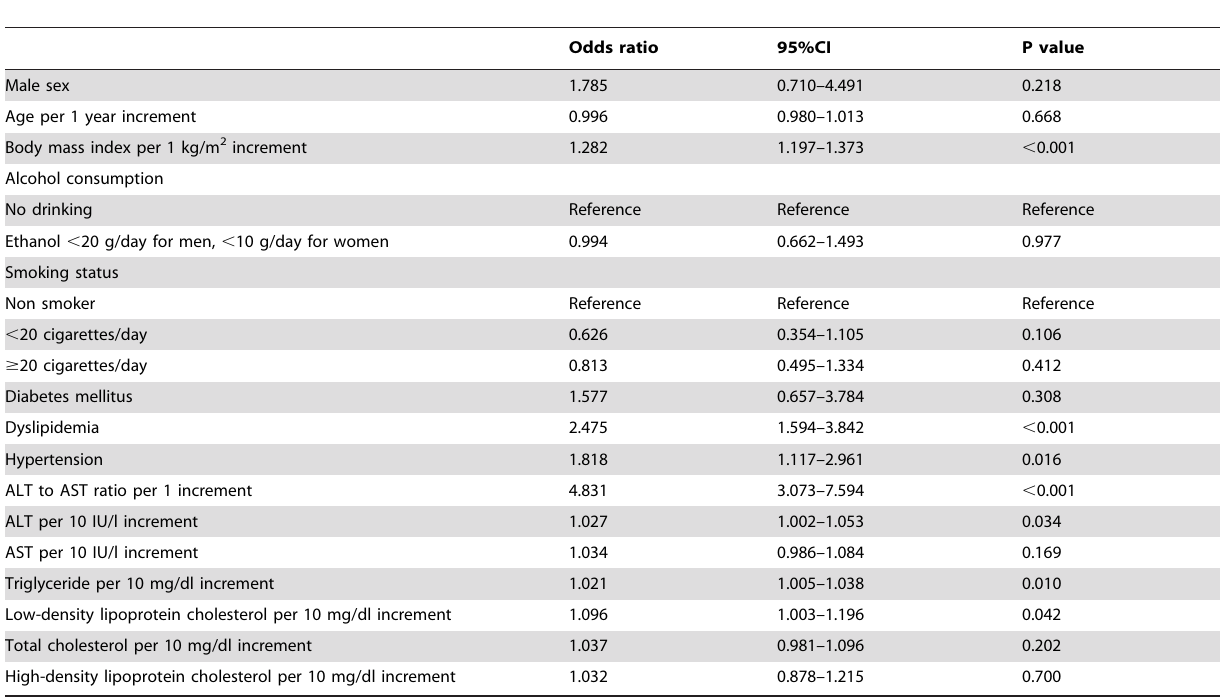
Table 2. Univariate analysis to estimate the associations of non HIV-specific variables with nonalcoholic fatty liver disease.